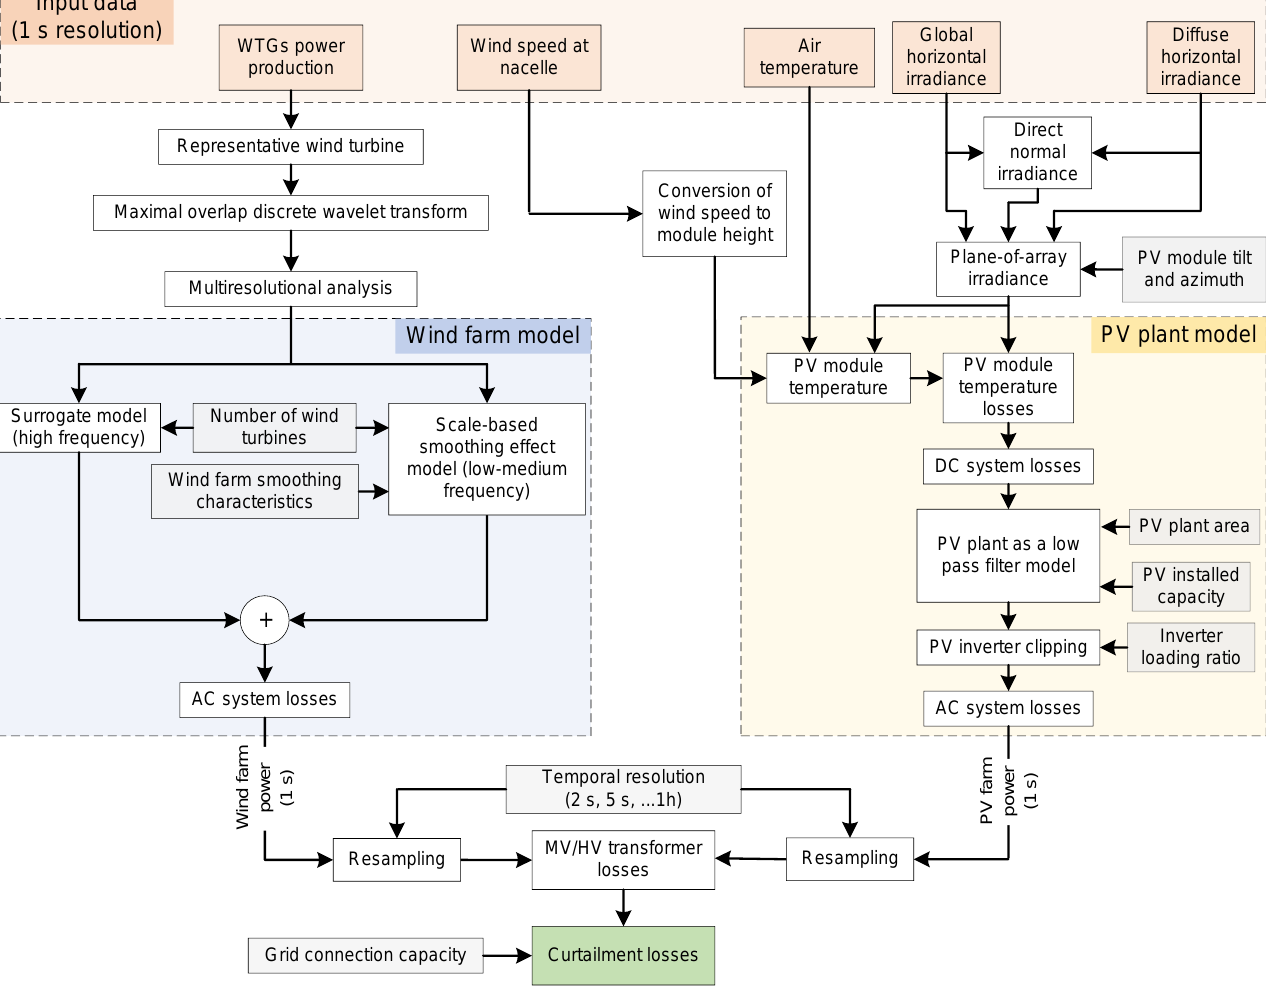
Figure 1. A simplified graphical representation of the main steps described in the